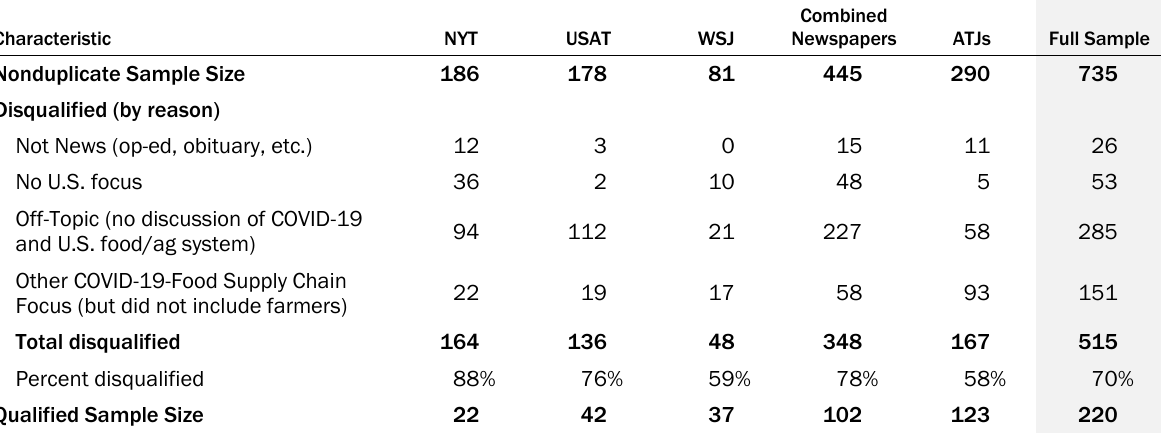
Table 1. Number of Articles in Sample Based on Inclusion and Exclusion Criteria Characteristic NYT Nonduplicate Sample